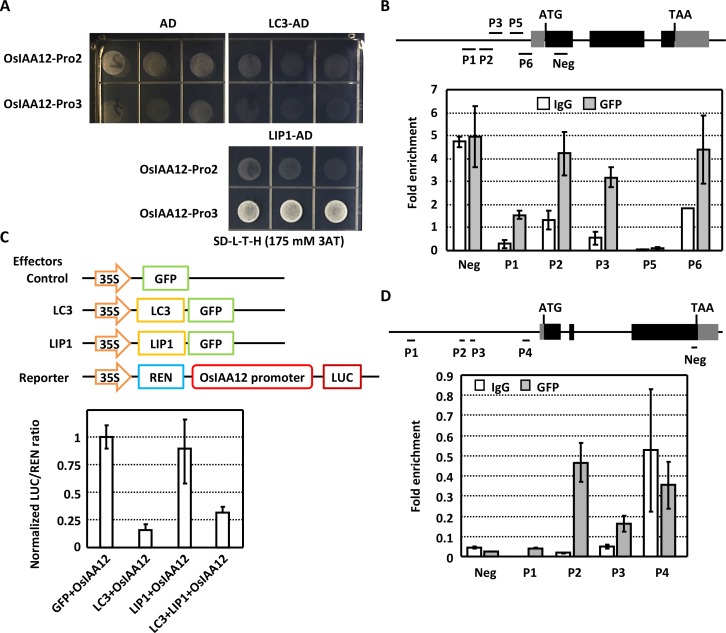
LIP1 directly binds to OsIAA12 and OsGH3.2 promoters.(A) Yeast one-hybrid analysis shows that LIP1, while LC3 does not, binds to the OsIAA12 promoter region. Yeast transformants were grown on synthetic dropout (-Leu/-Trp/-His) plates with 3-AT (175 mM) for 3 days. Promoter regions Pro2 (-1709 to -915 bp) and Pro3 (-914 bp to 0 before the ATG) were subcloned into pHIS2 vector. AD vector was used as negative control.(B) ChIP-qPCR analysis demonstrates the direct binding of LC3 complex with OsIAA12 promoter. Various DNA fragments (P1, P2, P3, P5, P6) of OsIAA12 promoter were amplified by ChIP-qPCR using the indicated primer sets respectively. DNA fragment at coding region was amplified and used as a negative control. Experiments were repeated three times and results were normalized with the amounts of corresponding fragments in input. Data are shown as means ± SE (n>3). (C) Dual luciferase transcriptional activity assays show that LC3-LIP1 suppresses the OsIAA12 transcription. Constructs for transient assays are schematically shown (upper). Both effector and reporter constructs were co-transformed into rice protoplasts. Relative activities of reporter activity (LUC) to the normalization standard (Renilla) were calculated by setting the relative ratio of LUC/REN in control as 1. Experiments were biologically repeated three times and data are presented as means ± SD. (D) ChIP-qPCR analysis demonstrates the direct binding of LC3 complex with OsGH3.2 promoter. Several DNA fragments (P1-P4) of OsGH3.2 promoters were amplified by ChIP-qPCR using the indicated primer sets respectively. Experiments were repeated three times and results were normalized with the amounts of corresponding fragments in input. Data are shown as means ± SE (n>3).